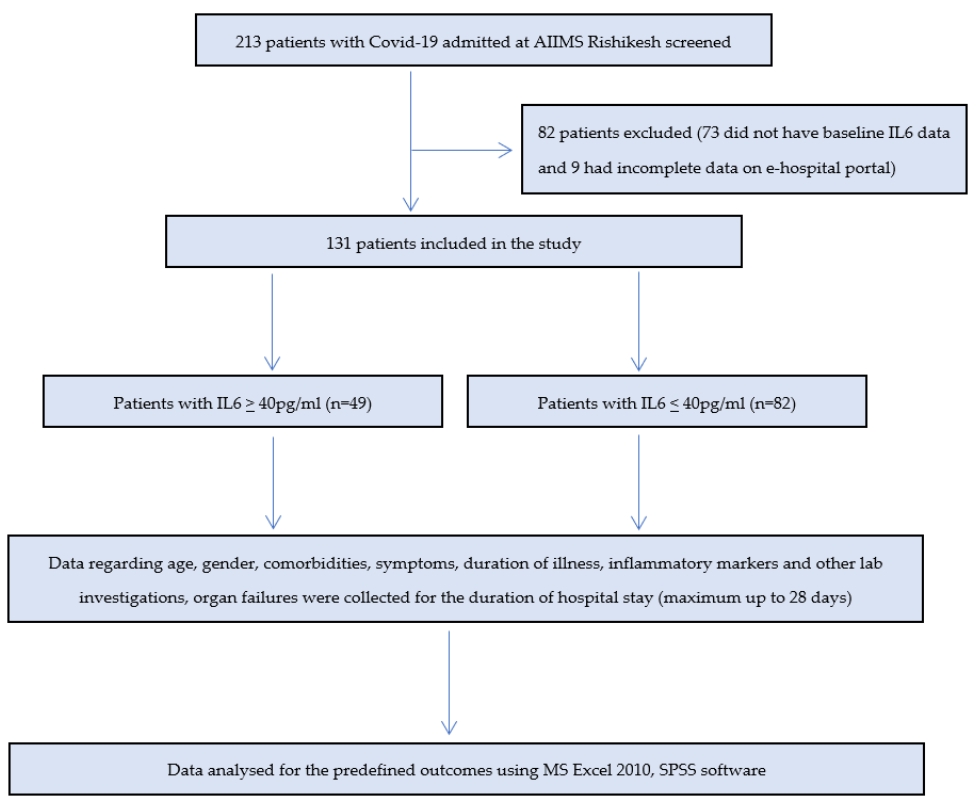
Figure 1. Flow of study. Table 1. General characteristics of the patients at admission (qCSI—quick COVID ‐ 19 severity score, P/F—PaO2/FiO2 ratio).